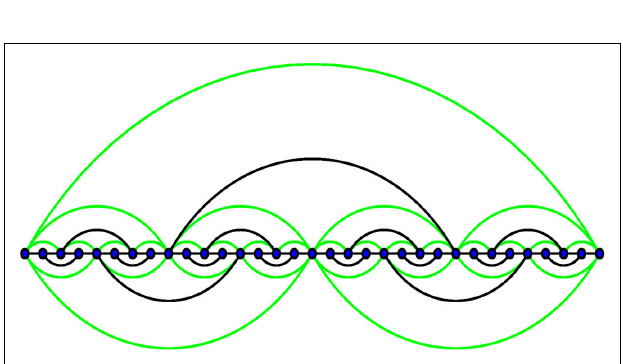
FIGURE 1 | Depiction of the 3-regular network HN3 on a semi-infinite line, here drawn suggestively as a model for hierarchically organized transport. Many goods and services are distributed in a small-world hierarchical manner before they get delivered in a real-world geometry.